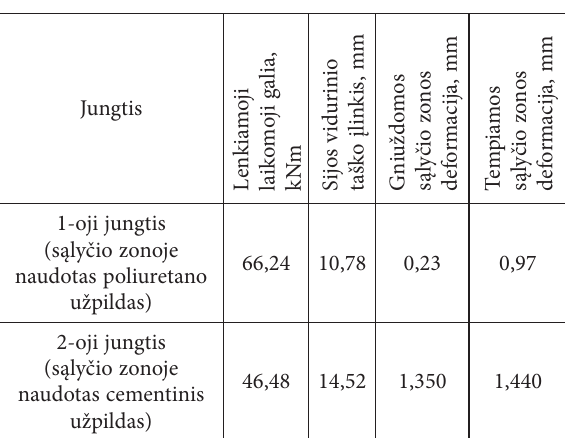
Table 2. Joints’ rotational bearing capacities and deformations at failure